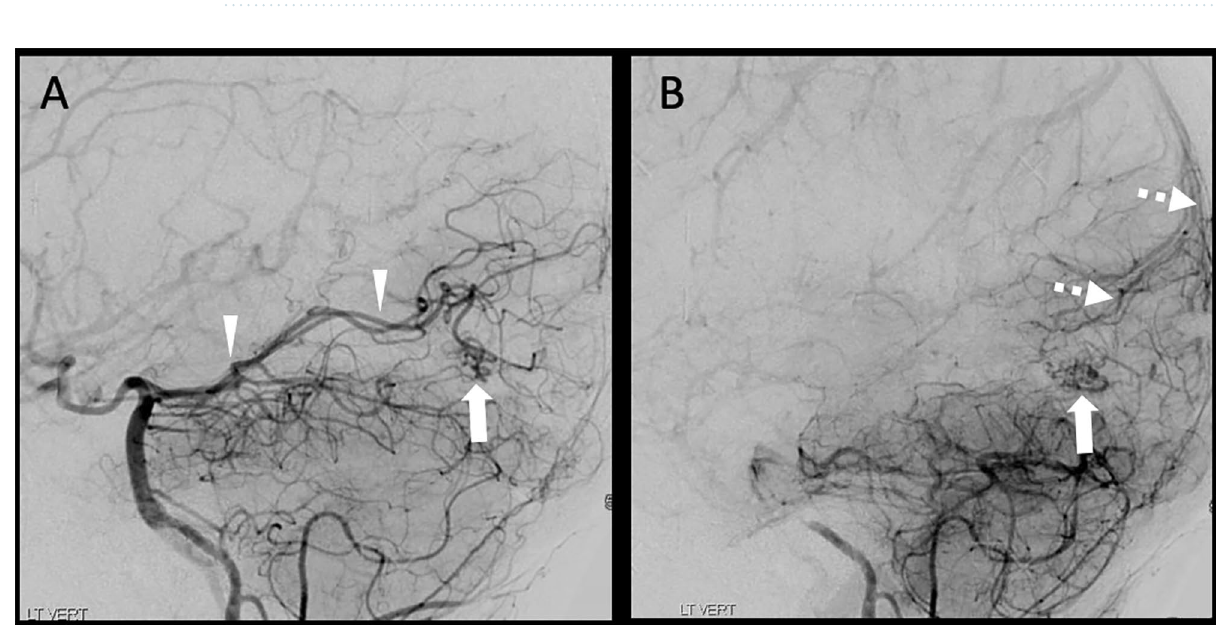
Figure 5. Lateral digital subtraction angiography from the same patient as Fig. 4 in the arterial ( A ) and early venous ( B ) phases demonstrating a small vascular nidus (arrow) supplied by the left posterior cerebral artery (arrowheads) and early filling of the superior sagittal sinus by cortical veins (dashed arrow) due to arteriovenous